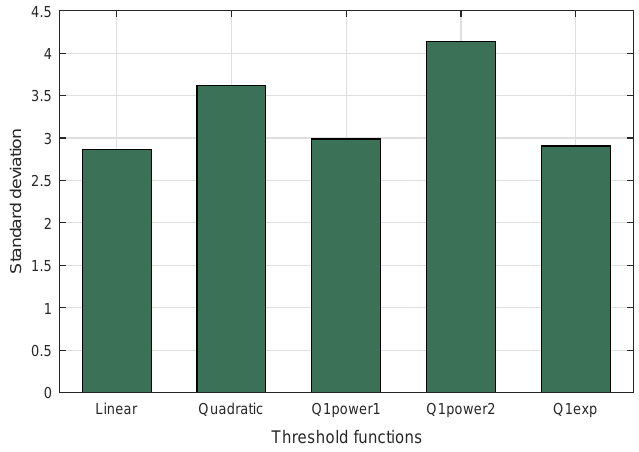
Figure 12. Standard deviation for threshold functions in